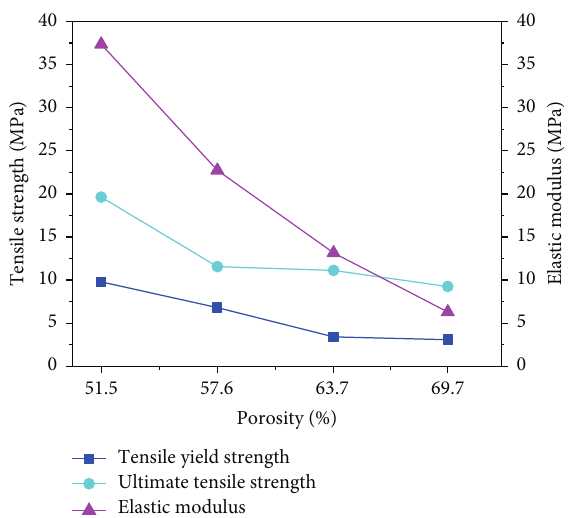
Figure 14: Effect of porosity on the tensile strength and the elastic